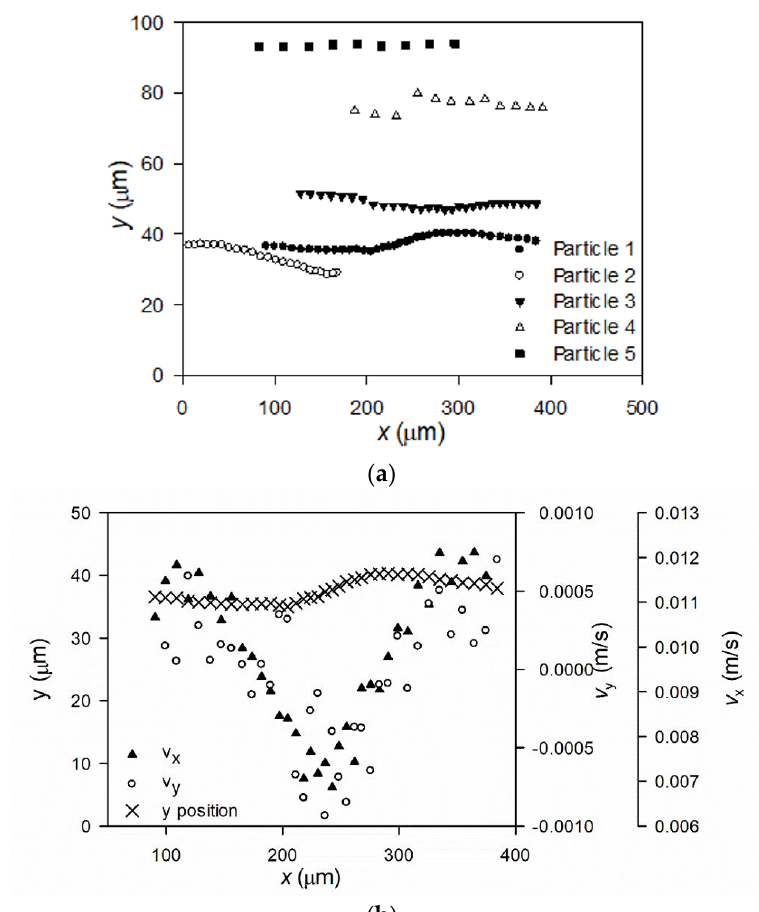
Figure 6. Particle movements of five tracked particles from recordings of filtrations conducted with lowly charged particles filtered at 2 bar and a crossflow velocity of 0.13 m/s ( a ). Plot ( b ) shows the movement of Particle 1 from ( a ) along with the calculated velocity of the particle along and towards the membrane fiber.